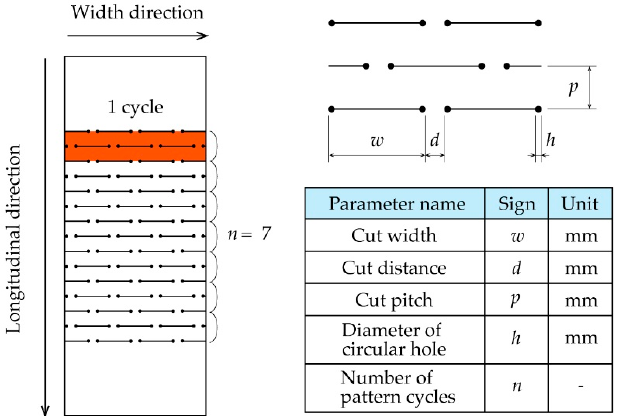
Figure 1. Parameters of a kirigami structure and cut patterns.